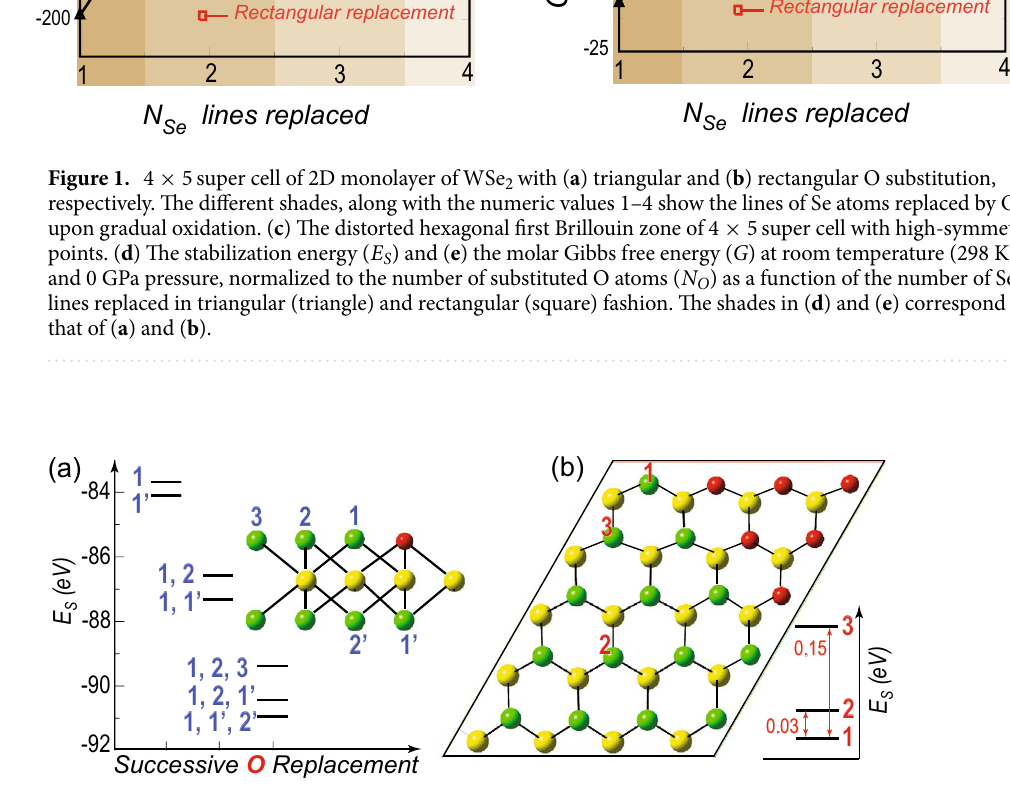
Figure 2. ( a ) 2 × 2 super cell of a 2D monolayer of WSe 2 with one Se atom of the top surface replaced by the O atom. The numeric values 1, 2, 3 ( 1’, 2’) show the location of further O replacement in the top (bottom) surface. The adjoining plot shows the stabilization energy of the system (horizontal line) with successive O replacement. The associated numeric value corresponding to each symbol shows the position of the O replacements in the system. ( b ) 4 × 5 super cell of a 2D monolayer of WSe 2 with triangular O substitution ( N O = 12). The numeric values 1, 2, 3 show the next O substitution location in the system. The adjoining plot shows the relative stabilization energy of the system (horizontal line) with O substitution. The numeric value associated with each symbol shows the location of the O substitution in the system. Both the stabilization energy schemes in ( a ) and ( b ) highlight O atom diffusion’s most energetically favorable position in these TMD